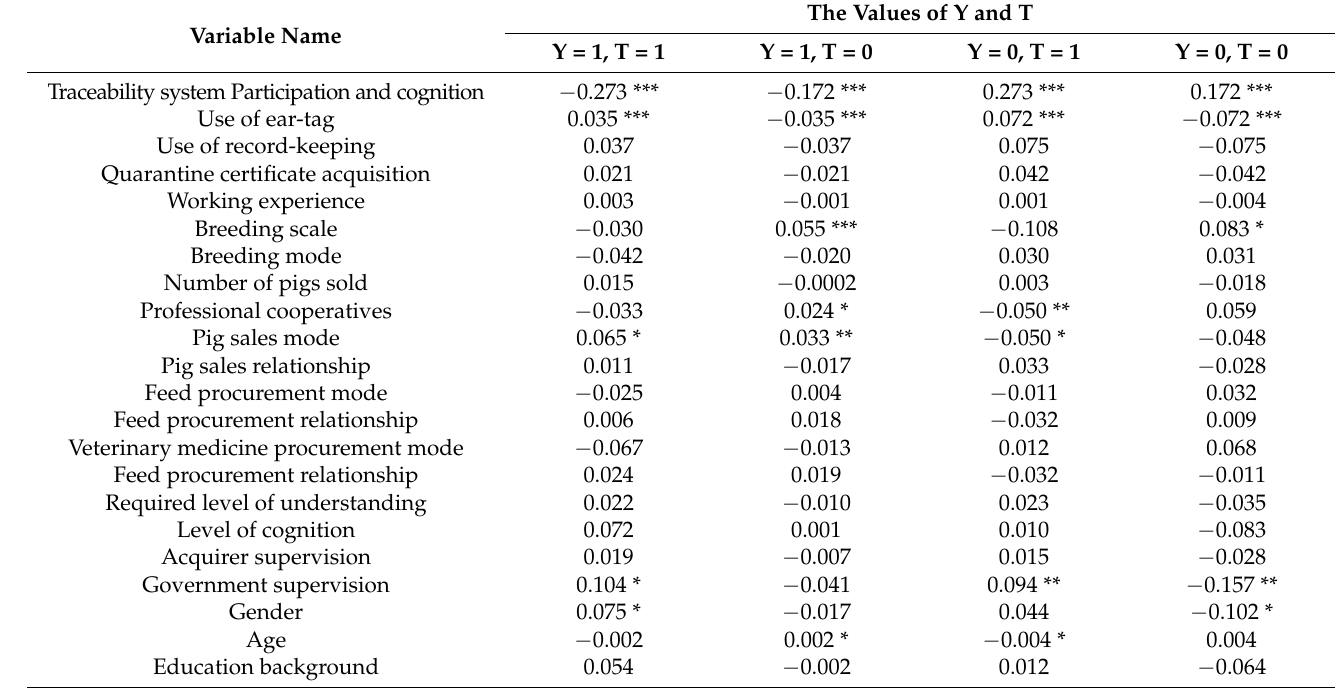
Table 5. Average marginal effects of the variables in the